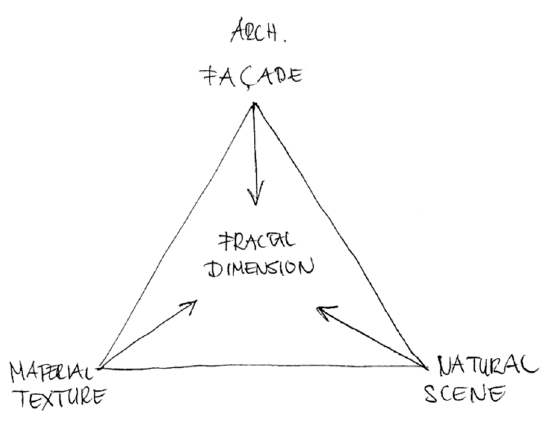
Figure 5. The comparability of the patterns from different sources—architectonic façades, natural scenes, and textures of building materials—through their Hausdorff dimensions.